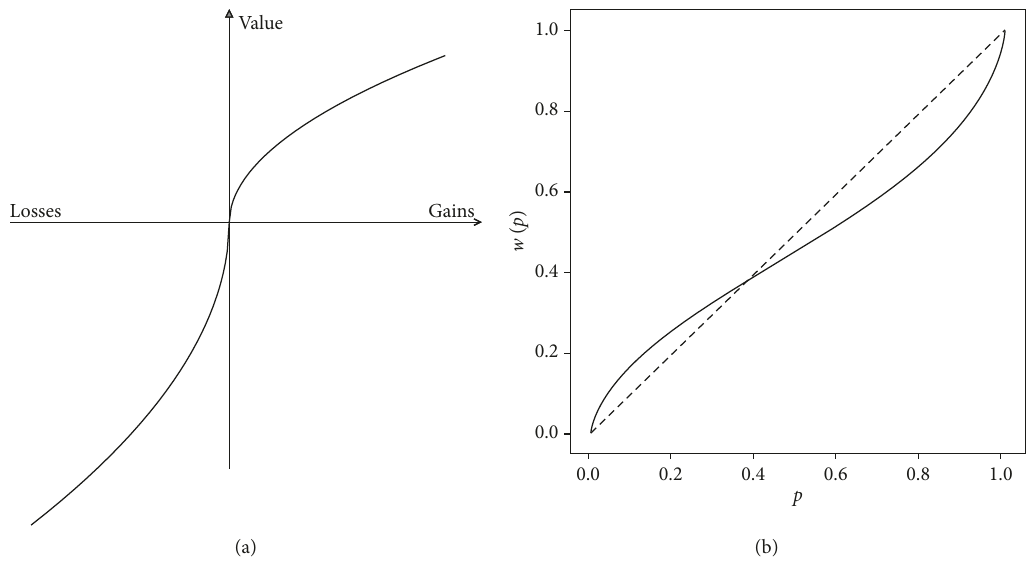
Figure 3: (a) Value function. (b) Probability weighing